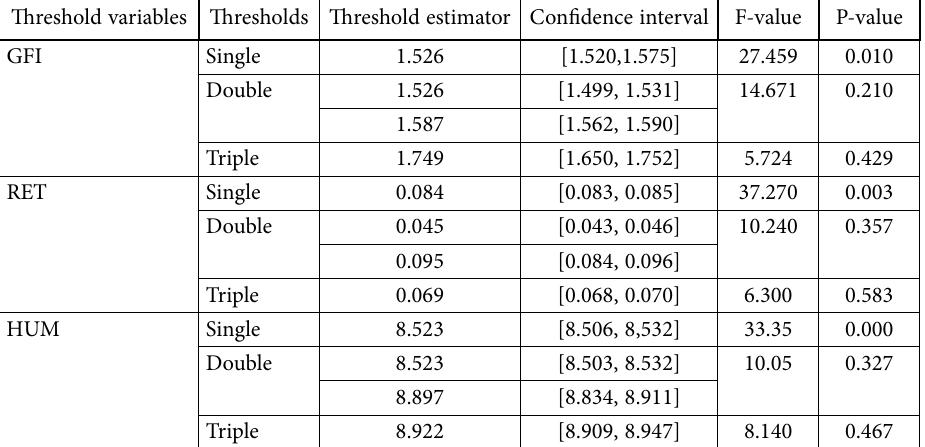
Table 7. Threshold effect test Threshold variables Thresholds Threshold estimator Confidence interval